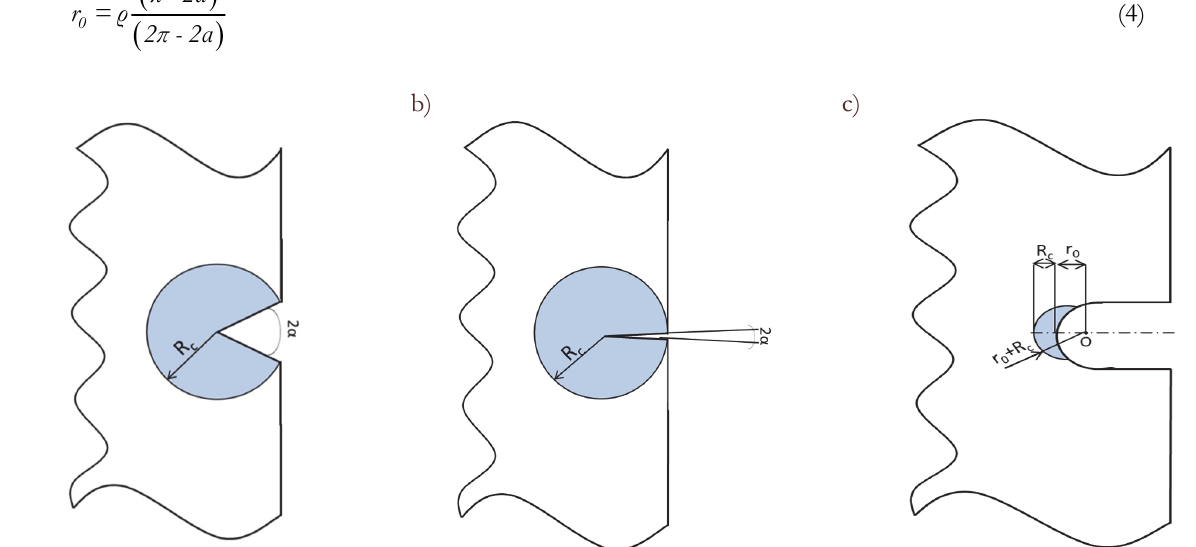
Figure 3: Control volume under mode I loading for: (a) sharp V-notch, (b) crack case and (c) U notch